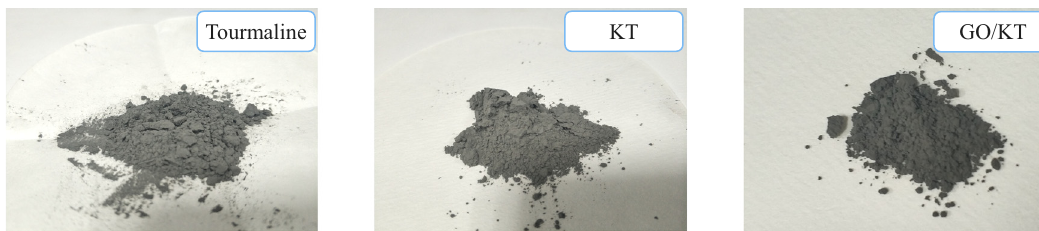
Figure 4: Macromorphology of tourmaline before and after modi fi